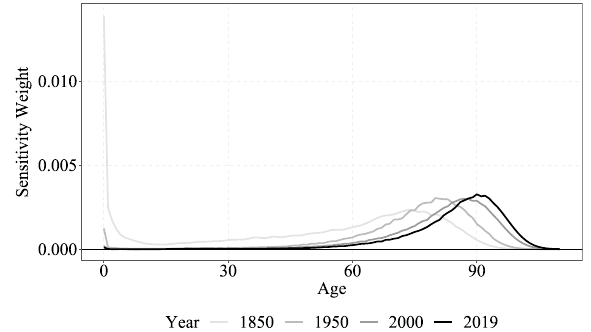
Fig. 1 Sensitivity Weight in Sweden from